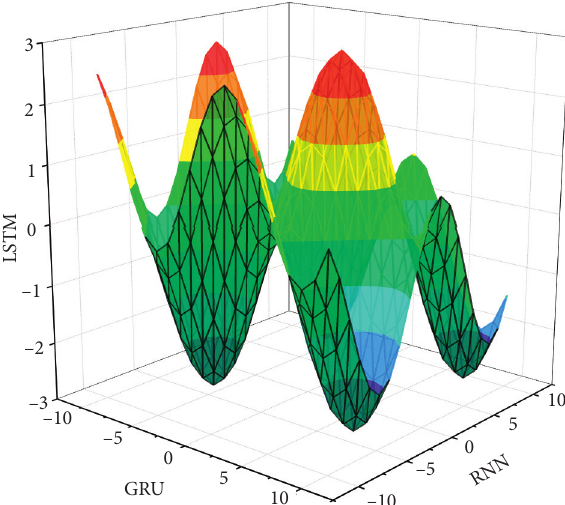
Figure 6: Graph of loss value